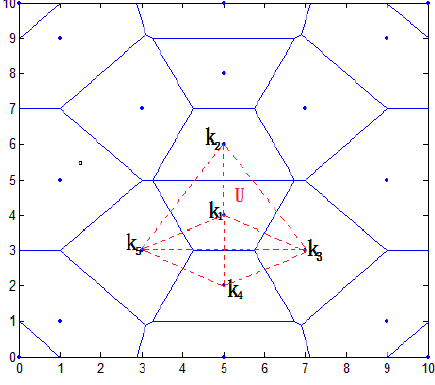
Figure 5. The target node being ( a ) inside and ( b ) outside the triangle area.